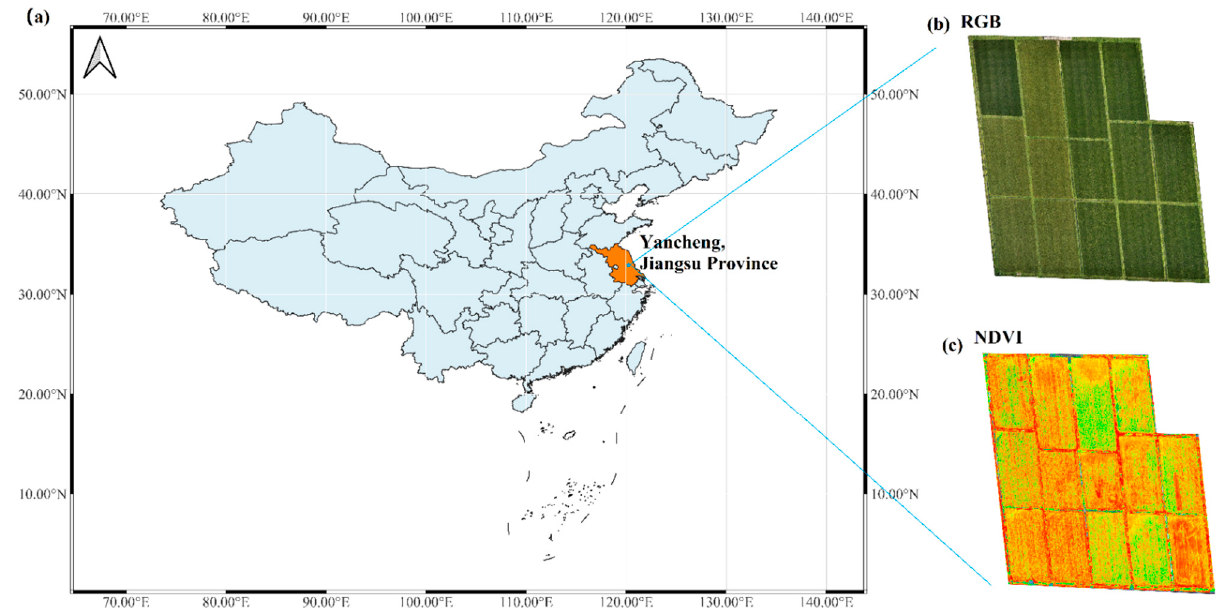
Figure 1. Location of the study site ( a ) and the experimental fields ( b , c ). ( b ) is the visible image (RGB) and ( c ) is the NDVI image, both taken on 26 June 2020.